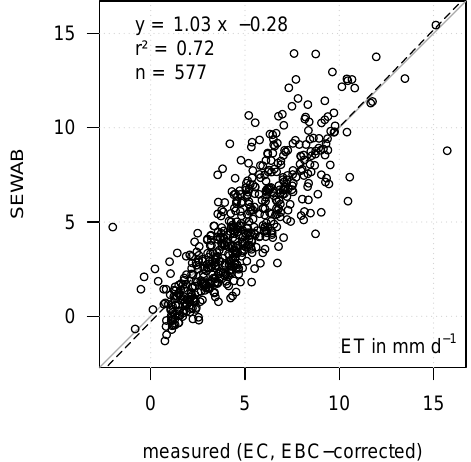
Figure B1. Scatter plot of measured vs. SEWAB modelled S RefEC evapotranspiration (ET) over 61 days of 2010 (3 June to 2 August) at Kema. Measured and modelled values are restricted to high data quality (flag 1–3 out of a scheme ranging from 1 to 9, Foken et al., 2004). Measured EC data is corrected according to the surface en- ergy imbalance with the buoyancy flux correction. sured hourly medians of net ecosystem exchange ranged be- tween − 2.3 and 1.0 gC m − 2 d − 1 over the course of the day, and modelled medians between − 2.7 and 1.0 gCm − 2 d − 1 . The wide range of measured NEE from − 6 gCm − 2 d − 1 to 1 gCm − 2 d − 1 at mid-day results from variable moisture con- ditions during the monsoon season and is consistent with chamber-based observations at a similar spot near Nam Co station (Hu et al., 2013). At Nam Co the model overestimated the CO 2 uptake espe- cially in the afternoon hours, indicating a larger influence of soil respiration than currently represented by the model. Sim- ulated soil respiration depends on simulated driving variables (soil temperature and moisture) and parameters. The latter have not been measured at Nam Co directly; instead the val- ues from the Kema field site have been employed, eventually introducing the observed bias. Nevertheless, the correlation with r 2 of 0.90 between hourly medians of modelled and measured NEE (Fig. B4, right) was better than at